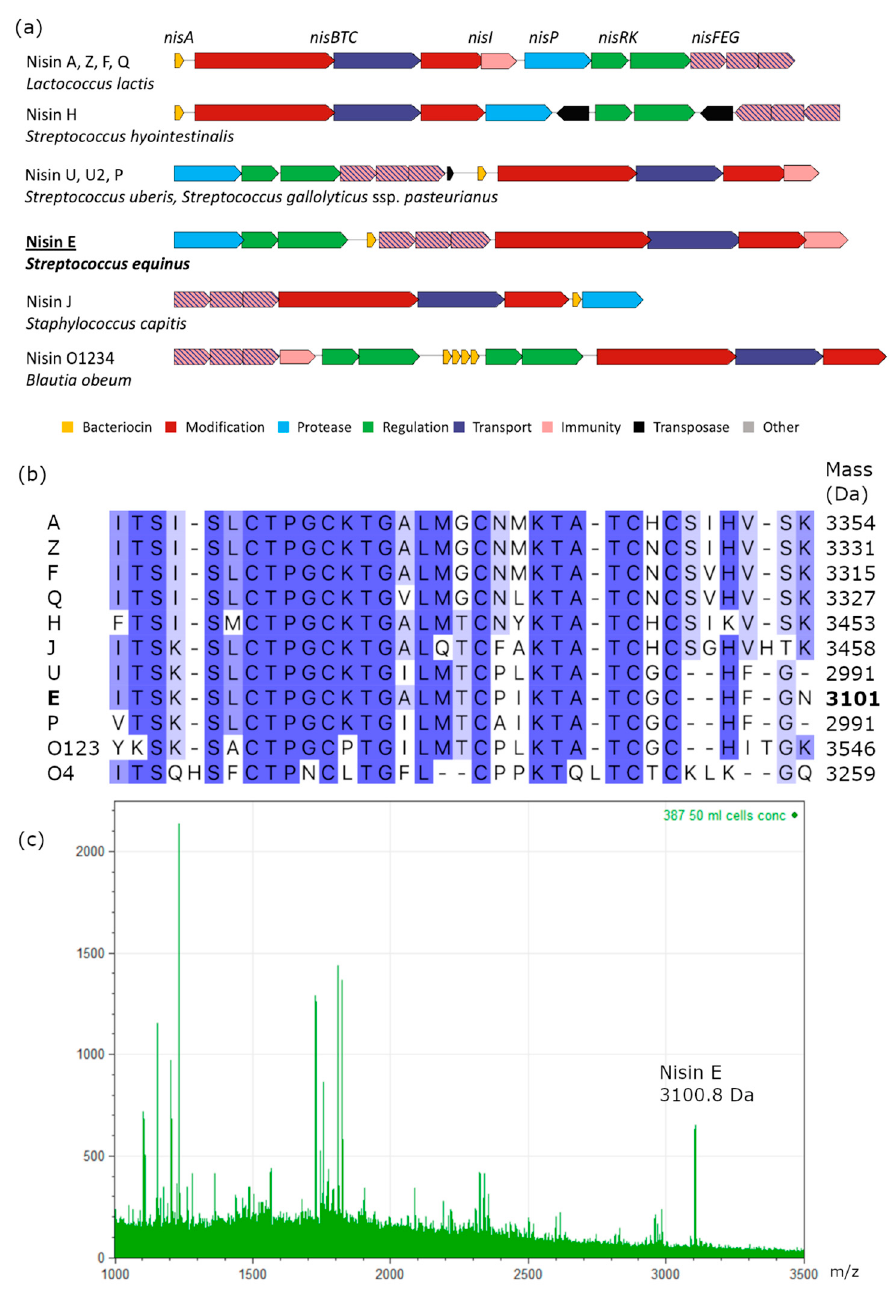
Figure 2. ( a ) Gene cluster structure comparison of natural nisin variants, including nisin E structure in Streptococcus equinus . ( b ) Amino acid sequence alignment of the nisin E propeptide to its related variants and nisin A; bold: predicted mass of nisin E. ( c ) MALDI-TOF colony mass spectra of S. equinus APC4007 displaying the nisin E mass at 3100.7 Da.